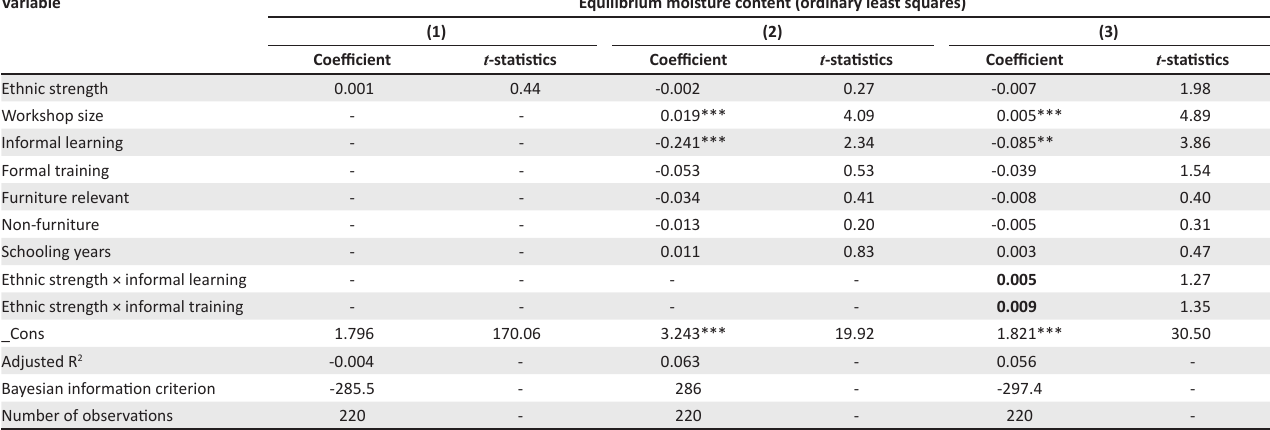
TABLE 6: Desiccation skill and ethnic strength. Variable Equilibrium moisture content (ordinary least